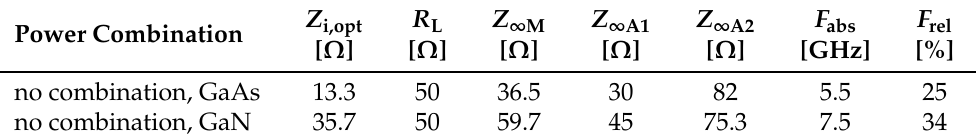
Table 4. Combiner parameters for a DPA adopting individual devices in GaAs and GaN technologies and corresponding 25% bandwidth estimated by the simplified